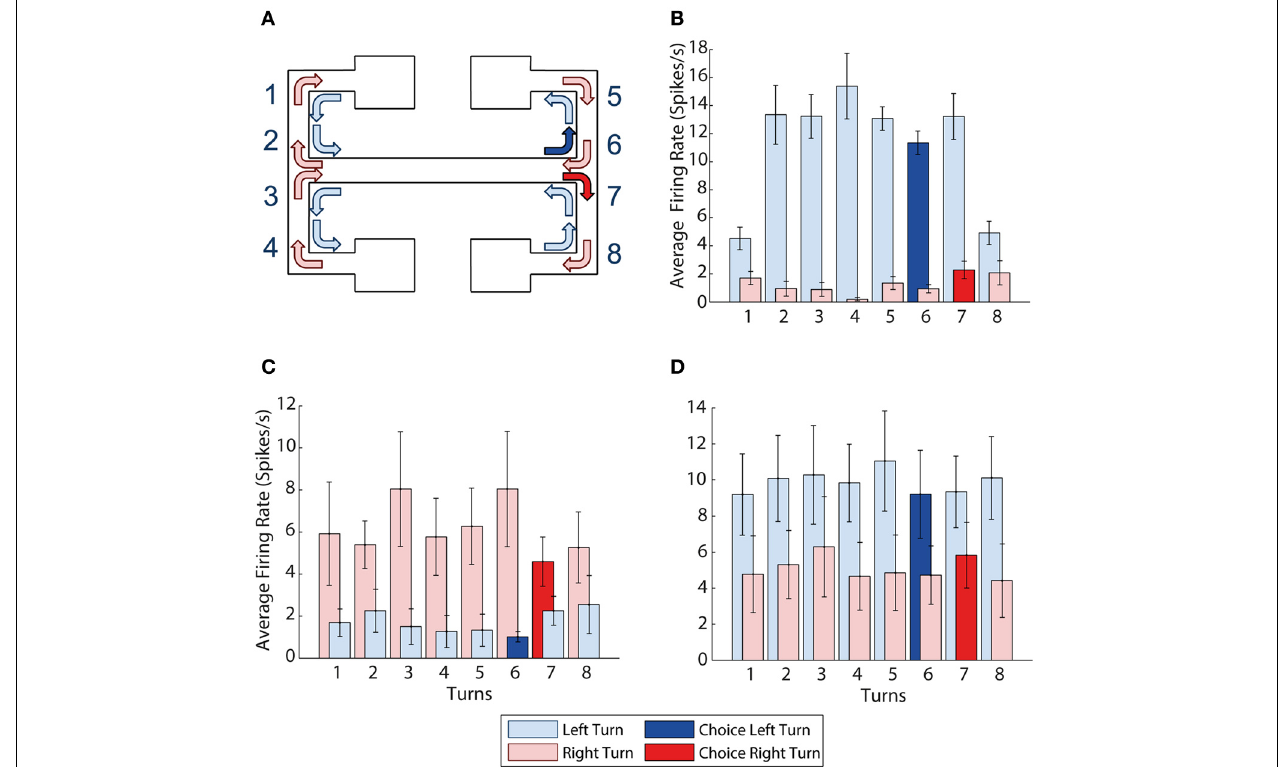
FIGURE 3 | mPFC activity is turn dependent. (A) Visualization of all the left and right turns in the maze, left turns shown with light blue arrows, right turns shown with light red arrows, choice right turn shown in solid red, choice left turn shown in solid blue. (B) Example of a neuron with activity selective for left turns. It shows higher average firing rates during all 8 left turns than